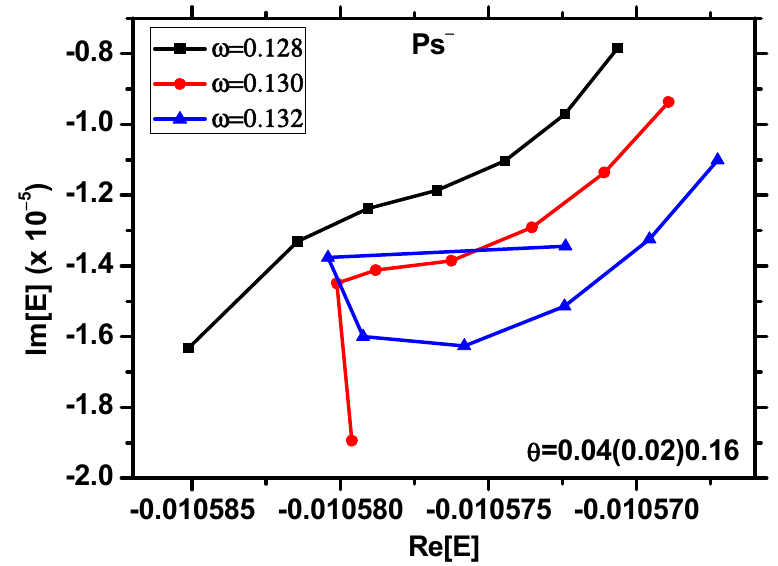
Figure 4. The rotational paths near the pole for the 1 P° (5) FR of Ps − lying below the Ps ( N = 5 ) threshold in the EP for three different values of the scaling parameter ω using 900-term ECW.